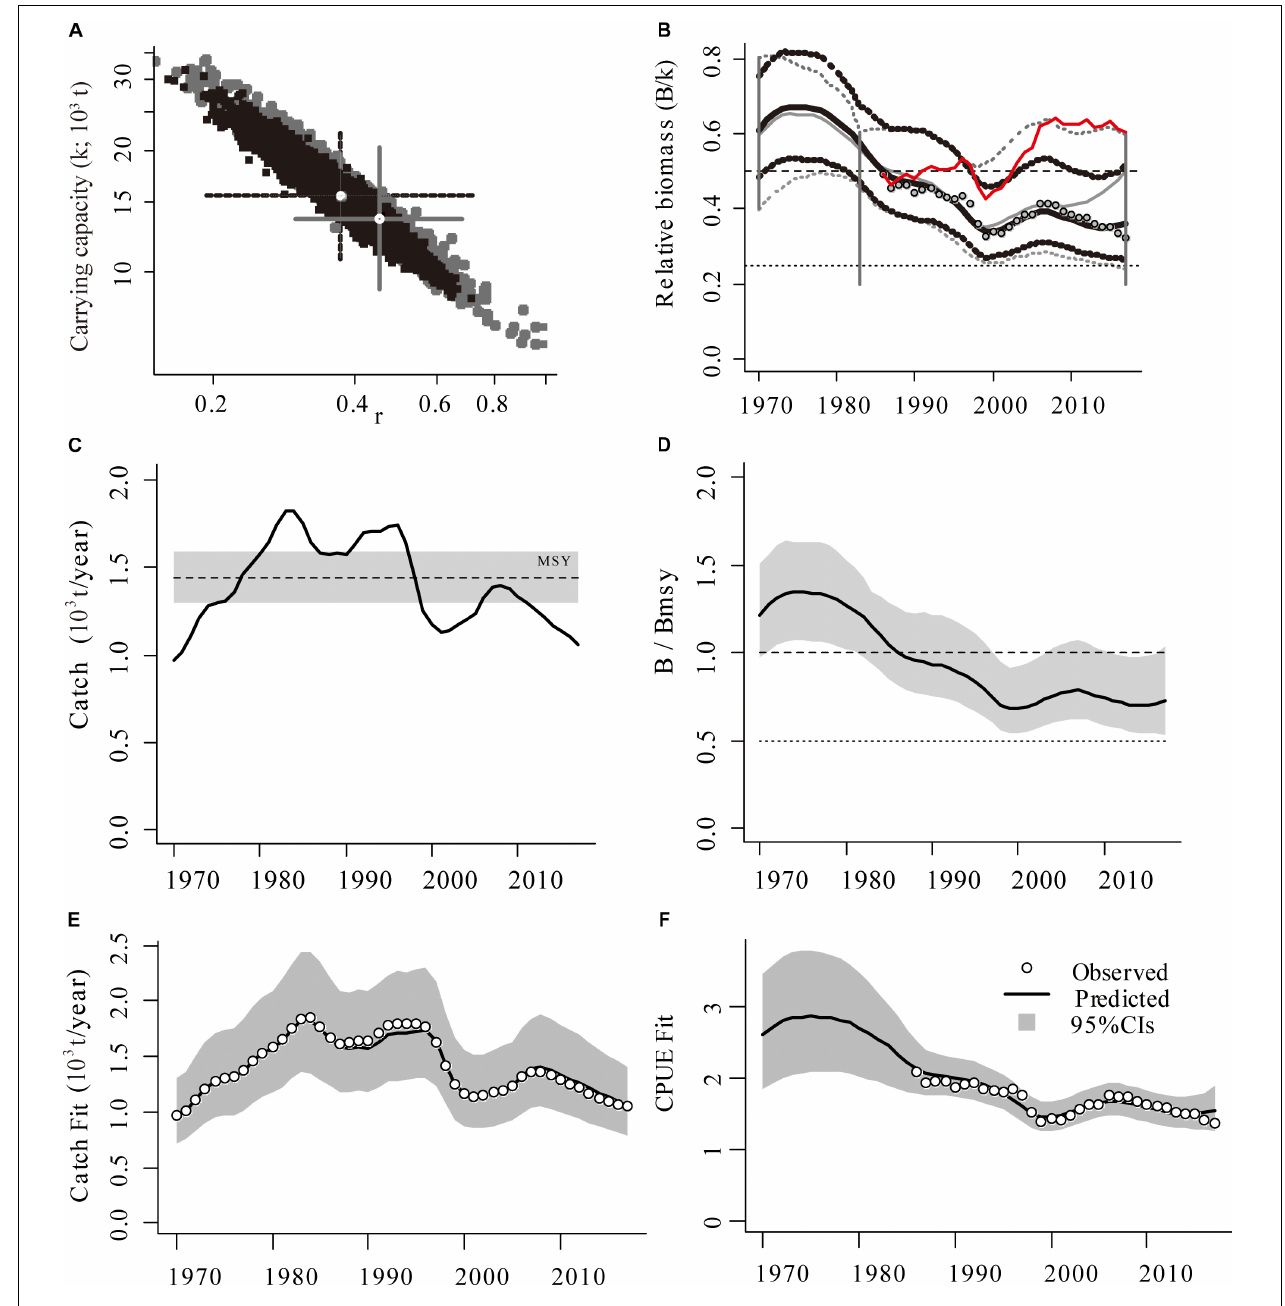
FIGURE 1 | (A) Example of the viable r – k pairs from CMSY (in gray) and BSM (in black) methods. (B) The crosses indicate the most probable pairs and their 95% confidence intervals (solid cross: CMSY; dotted cross: BSM; Red curve: the correction of CPUE for effort creep). (C) Catches relative to MSY with indication of 95% confidence limits in gray, and (D) development of predicted relative total biomass ( B/B MSY ), with the gray area indicating uncertainty. (E) The fit of the median of predicted catch, with approximate 95% confidence limits, to the observed catch (points), and (F) a similar graph for predicted vs. observed CPUE (for Paralichthys olivaceus